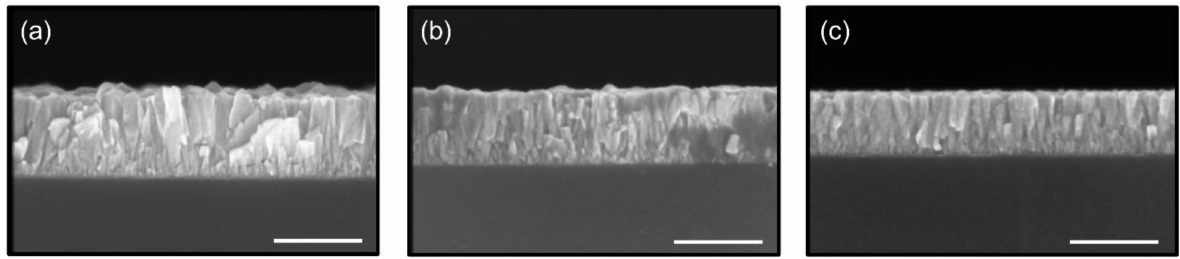
Figure 4. SEM cross-sectional images of ZnO thin films grown on Si substrates at ( a ) 100 ◦ C, ( b ) 80 ◦ C and ( c ) 60 ◦ C. Each ZnO thin film was obtained with 1000 Atomic Layer Deposition (ALD) loops. The scale bar corresponds to 200